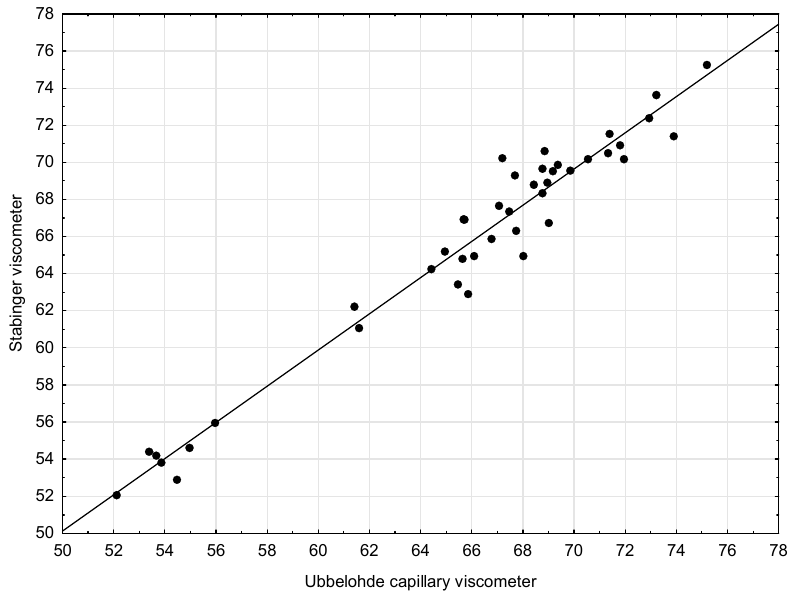
Figure 1. Scatter plots with regression lines for kinematic viscosity—Capillary viscometer and Stabinger viscometer.